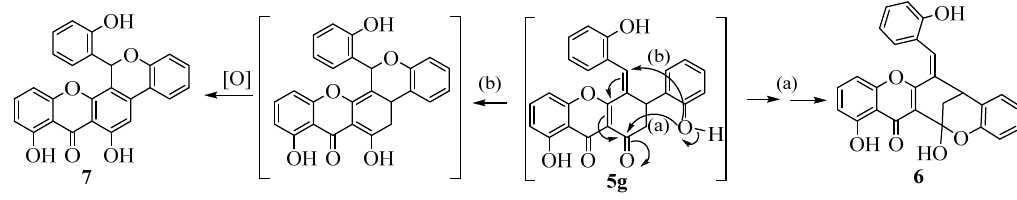
Scheme 2. Proposed